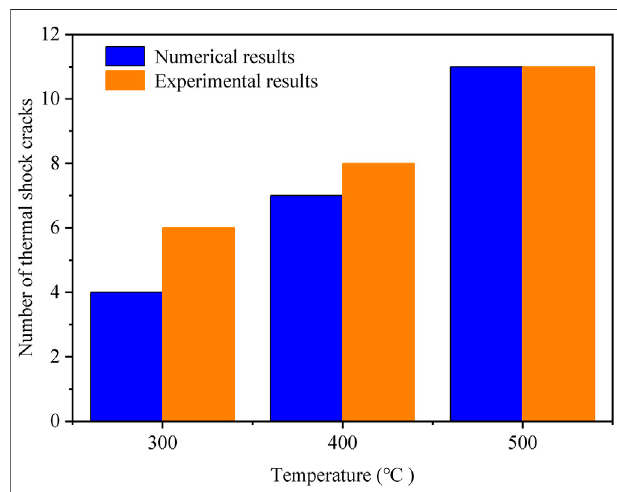
FIGURE 6 | Comparison of the number of long cracks in simulation results and experimental results (Liu et al., 2015) of the circular Al 2 O 3 specimen.